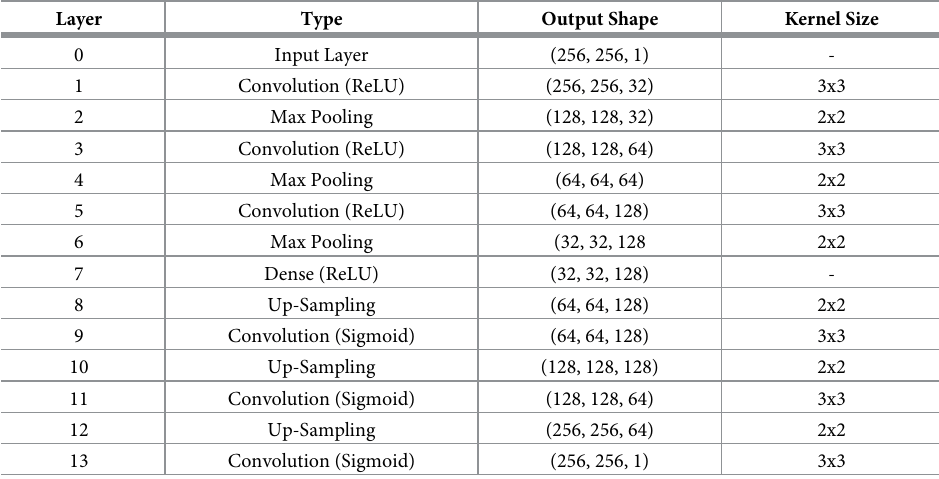
Table 1. Lung segmentation